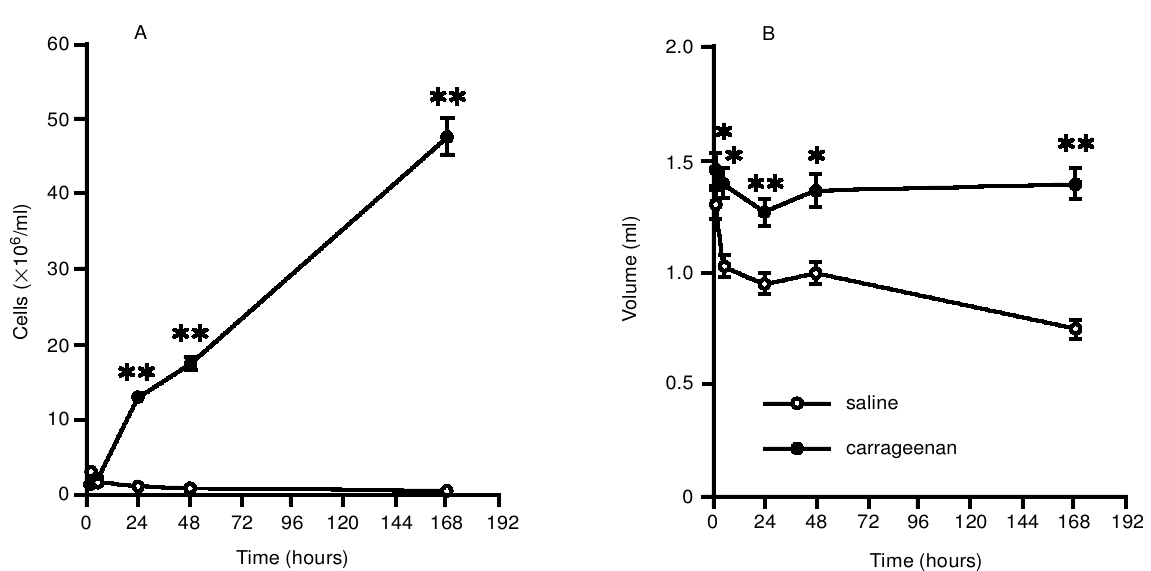
FIG. 1. Time course of total leukocyte number (panel A) and volume of exudate (panel B) in carrageenan-induced in¯ ammation. Animals were pretreated with 1 ml of sterile saline ( ± s ± ) or 1 ml of 1% carrageenan in sterile saline ( ± d ± ). Data are the mean SD of at least eight animals. P < 0 05, P < 0 01 according to Duncan’s test for multiple